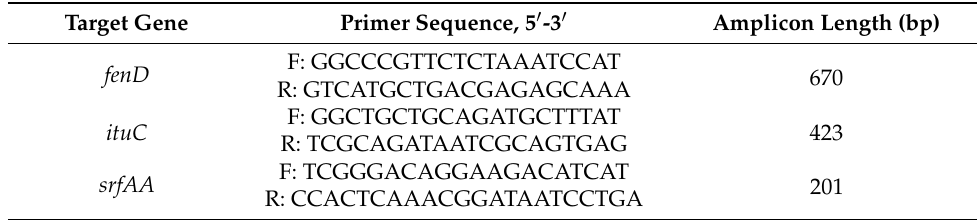
Table 1. PCR primers used for amplification of lipopeptide genes [35]. Target